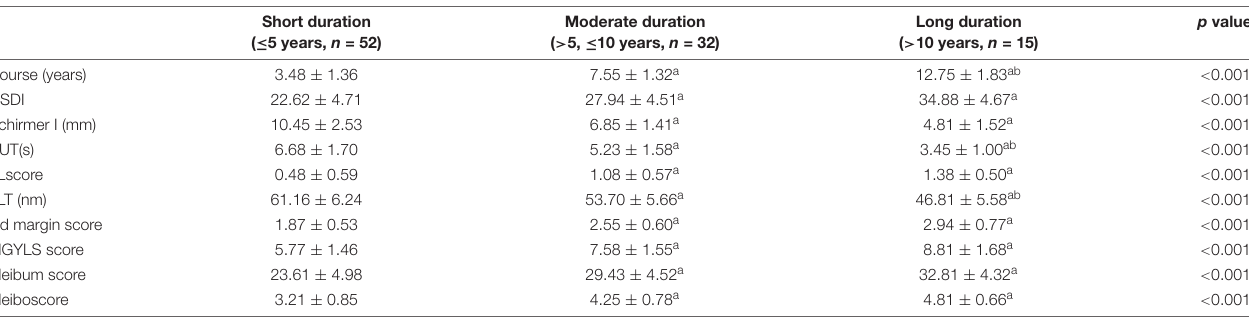
TABLE 5 | Tear film and meibomian gland parameters in long or short durations of